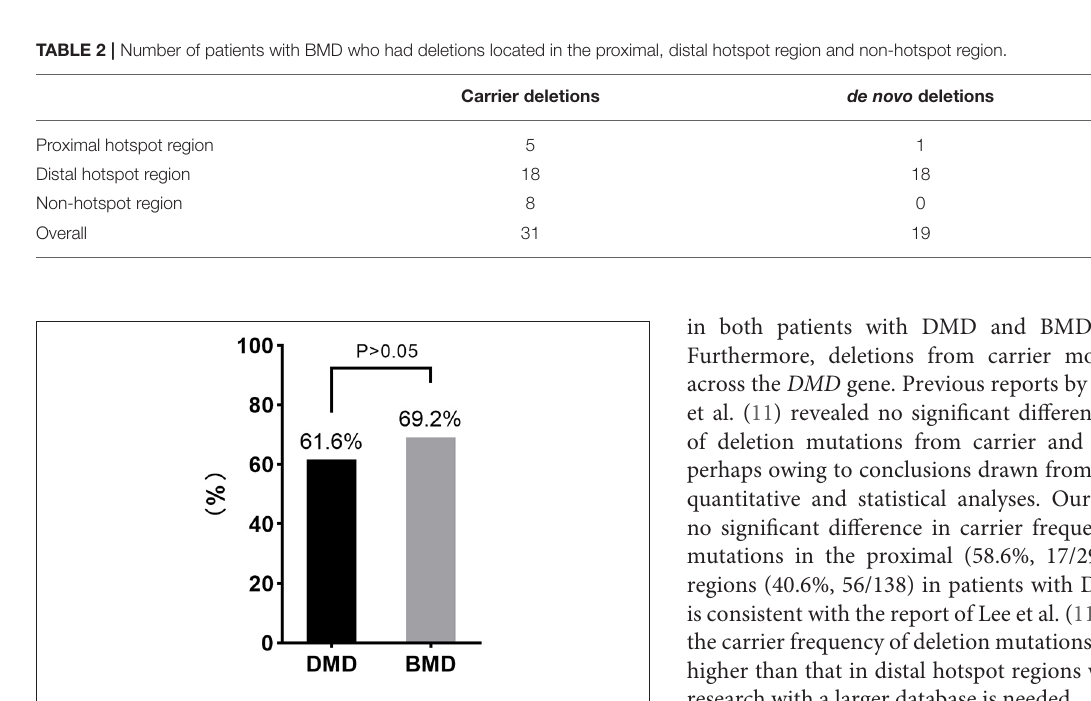
FIGURE 4 | Comparison of the carrier frequency of DMD and BMD. No significant difference between the carrier frequencies of DMD and BMD was observed using the Chi-square test ( P > 0.05).